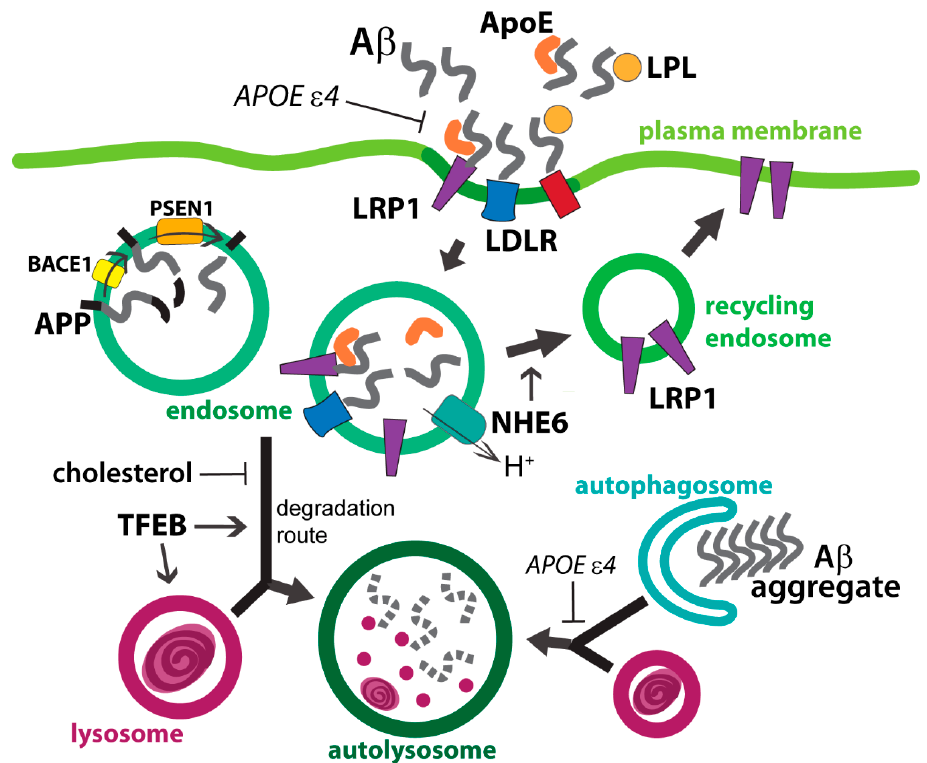
Figure 1. Uptake and endolysosomal processing of amyloid beta (A β ) and Apolipoprotein E (ApoE) in astrocytes. Astrocytes internalize extracellular A β and ApoE via low-density lipoprotein receptor-related protein 1 (LRP1) and low-density lipoprotein receptor (LDLR) surface receptors. Dissociation